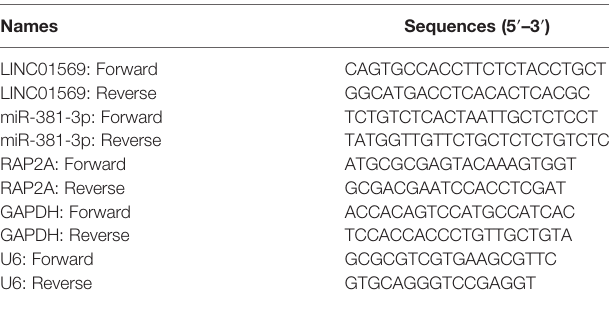
TABLE 2 | The primers used in this study for